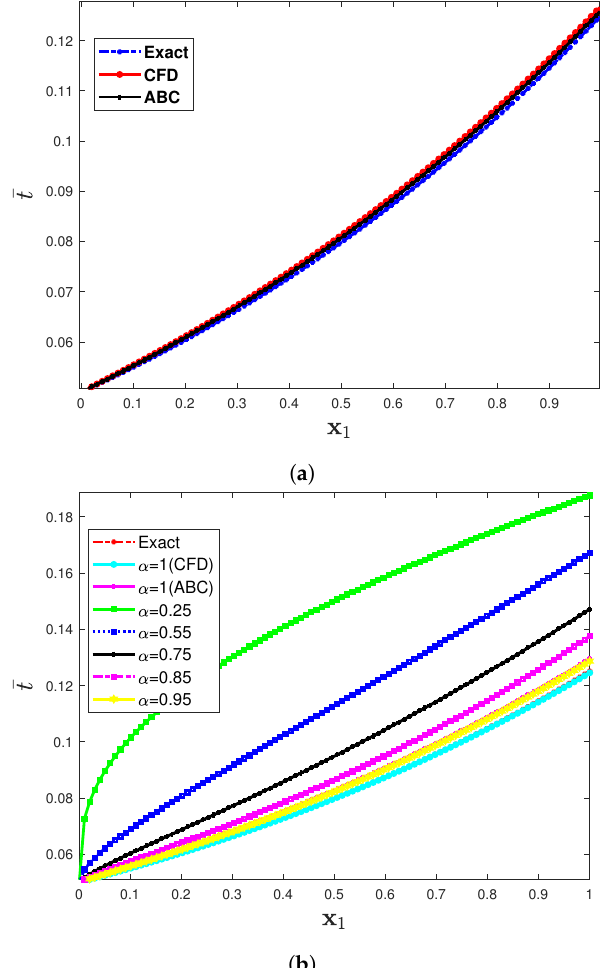
Figure 3. Two dimensional representation of f ( x 1 , ¯ t ) for Problem 1 at different fractional orders when the parameters are η = 0.05, θ = 1, β = 1, and ϕ = 0. ( a ) illustrates the comparison view of CFD and ABC operators with their exact solutions, while ( b ) shows the two dimensional view of the exact-approximate solution with different fractional-order in the CFD and ABC fractional derivative